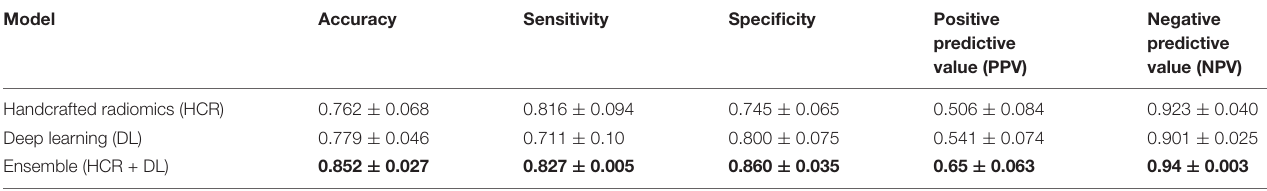
TABLE 3 | Comparison of diagnostic performance on the external test dataset for HCR, DL, an ensemble of HCR and DL, and in-silico trial with clinicians. Model Accuracy